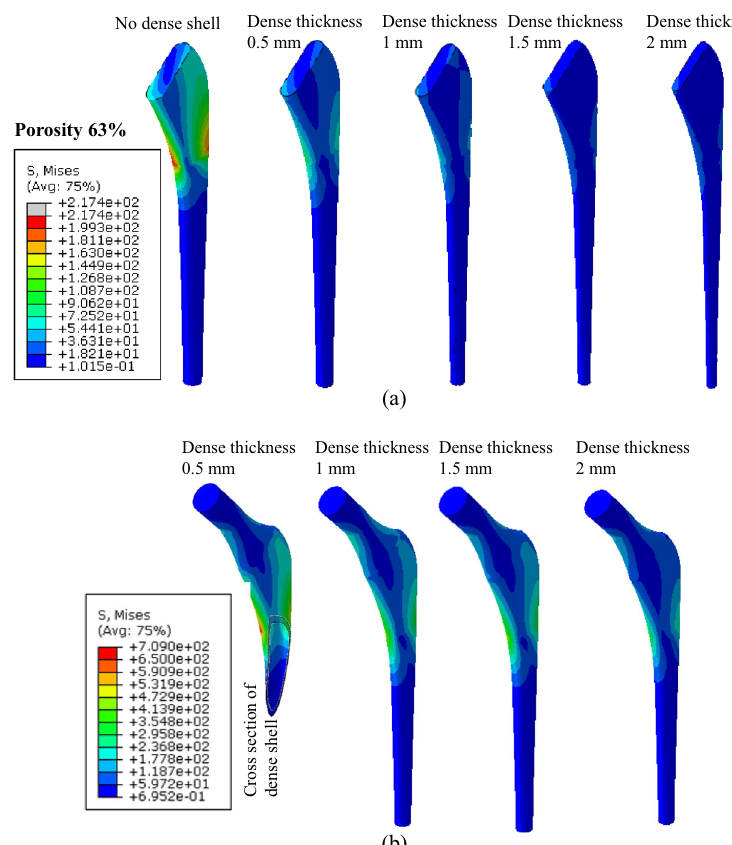
Fig. 6 Von Mises stresses (MPa) in femoral stem with a porosity of 63%; a stresses in the porous section of stem with different outer shell thickness, b stresses in outer dense shell with different